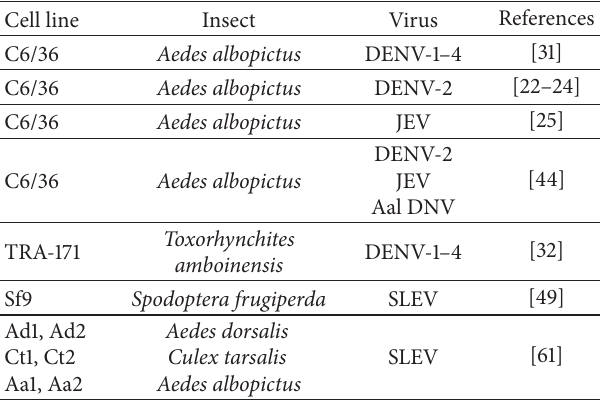
Table 1: Mosquito cell lines persistently infected with